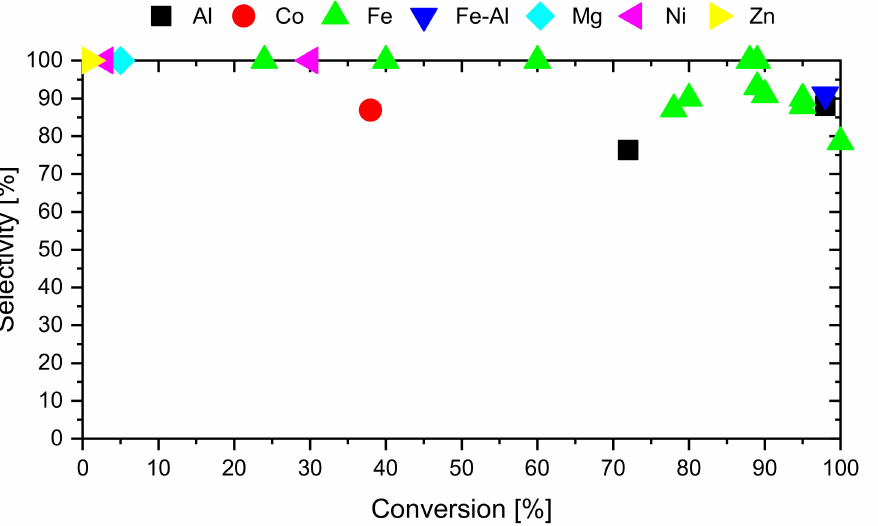
Figure 41. Summary of catalytic test results for vanadates and spinel-type catalysts in the literature